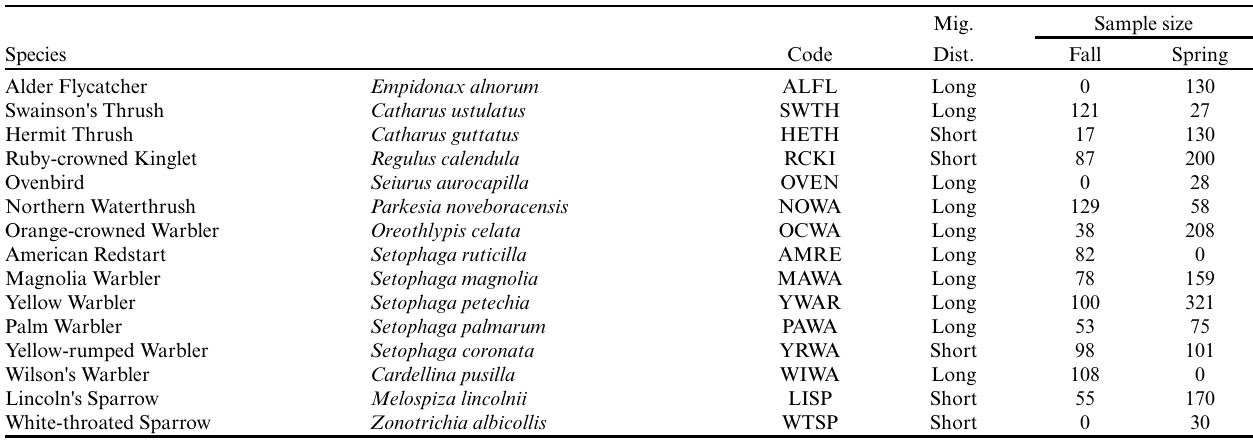
Table 1 . Study species and classification of migration distance (Wong et al 2003).